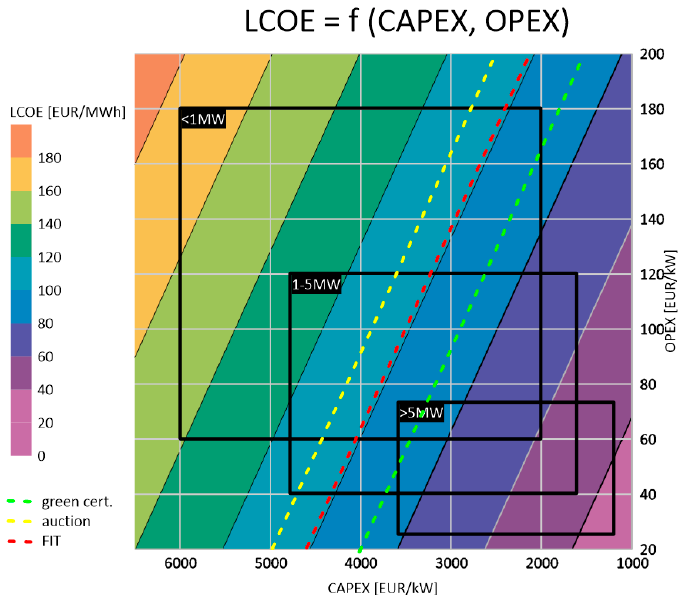
Figure 5. The total cost LCOE and possible revenues from support systems (green certificates, auc ‐